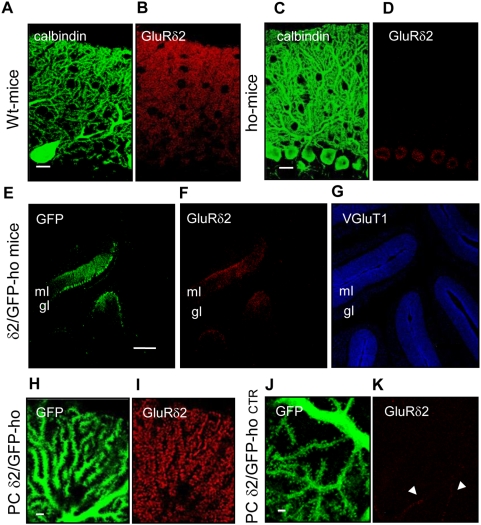

In vivo injection of L7-GFP and L7-GluRδ2 viruses in the mature cerebellum of ho-4J mice (δ2/GFP-ho mice).(A–D). Immunostaining of PCs labeled with anti-calbindin (green) and anti-GluRδ2 (red) antibodies in wild-type mice (A–B) and ho-4j mice (C–D). In the ho-4j mice the GluRδ2 truncated protein is retained in the PC soma. (E–F–G) Immunostaining of a cerebellar sagittal section from δ2/GFP-ho mice 4 weeks after in vivo injection. The infected PCs express GFP (green, E) and GluRδ2 (red, F). VGluT1 antibody (blue, G), used as an endogenous marker, labels the mossy fibers and the PF terminals in the granular (gl) and molecular layers (ml), respectively. (H–K) High magnification images of PCs expressing GFP (green) and GluRδ2 (red) in the distal dendrites of δ2/GFP-ho mice. Two populations of GFP-positive PCs are shown: PCs expressing GluRδ2 (red) (H–I) and the PCs with undetectable levels of GluRδ2 (δ2/GFP-ho CTR group) (J–K). The arrowheads indicate ectopic GluRδ2 in a different cell. Scale bars: A–D = 20 µm, E–G = 200 µm, H–N = 2 µm.